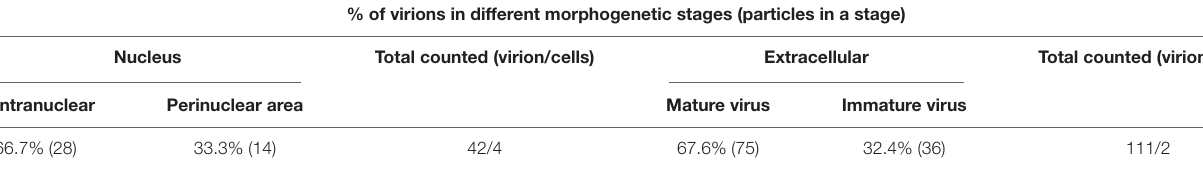
TABLE 2 | Virions observed in (cid:49) LORF5-infected DEF cells by electron